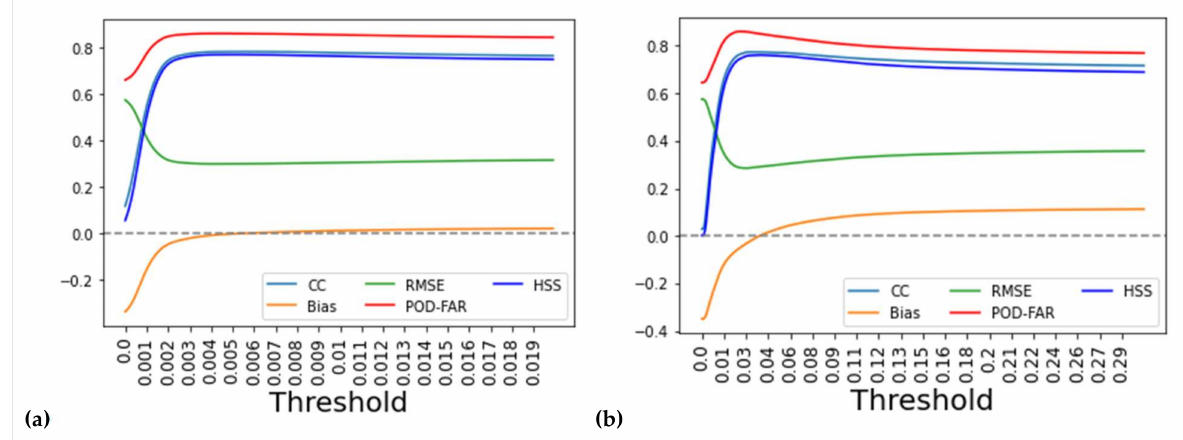
Figure 6. Threshold value-dependent statistical scores obtained from the comparison between MODIS CM and the proposed CM for the ( a ) 1.38 and ( b ) 1.61 µ m bands using the test dataset found in the pink box (Figure 2), for 1 June 2017, 02:15 UTC. Cyan, green, yellow, blue, and red lines indicate CC, RMSE, bias, HSS, and POD-FAR values,